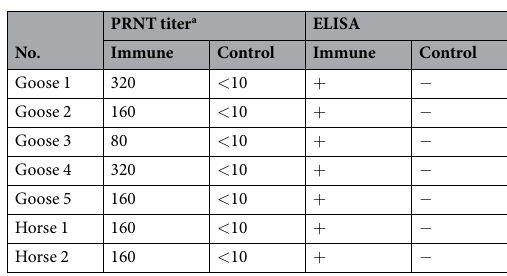
Table 1. Neutralizing antibodies derived from goose and horse sera. a The PRNT titer was expressed as the maximum serum dilution yielding a 50% plaque